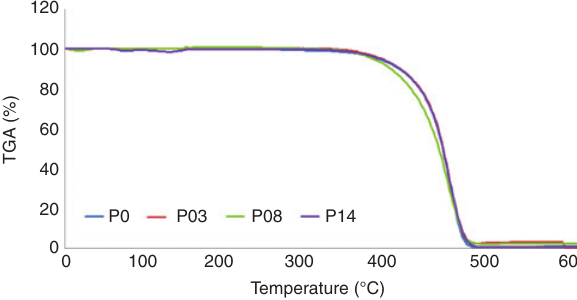
Figure 4: TGA curves of the polypropylene filaments.